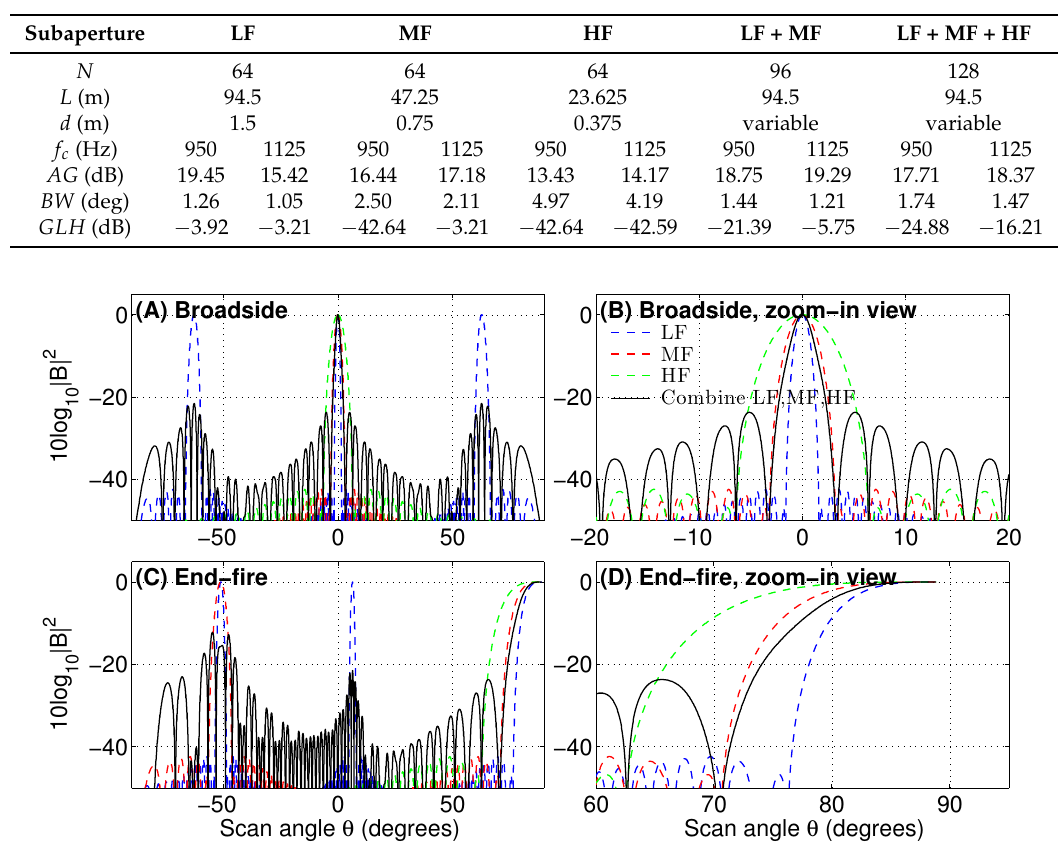
Table 1. The number of elements N , total array length L , inter-element spacing d , array gain AG , beam width BW , and maximum grating lobe height GLH of the conventional uniformly-spaced subapertures, including the low-frequency (LF), mid-frequency (MF) and high-frequency (HF) subapertures, and newly defined nonuniformly-spaced subarrays of the Office of Naval Research Five Octave Research Array for signals with 50 Hz bandwidth centered at f c = 950 Hz and f c = 1125 Hz, respectively. The azimuth of the incident signal θ 0 is set to be 0 for calculating broadside beam width and array gain, and is set to be ± 90 ◦ for calculating maximum grating lobe height.